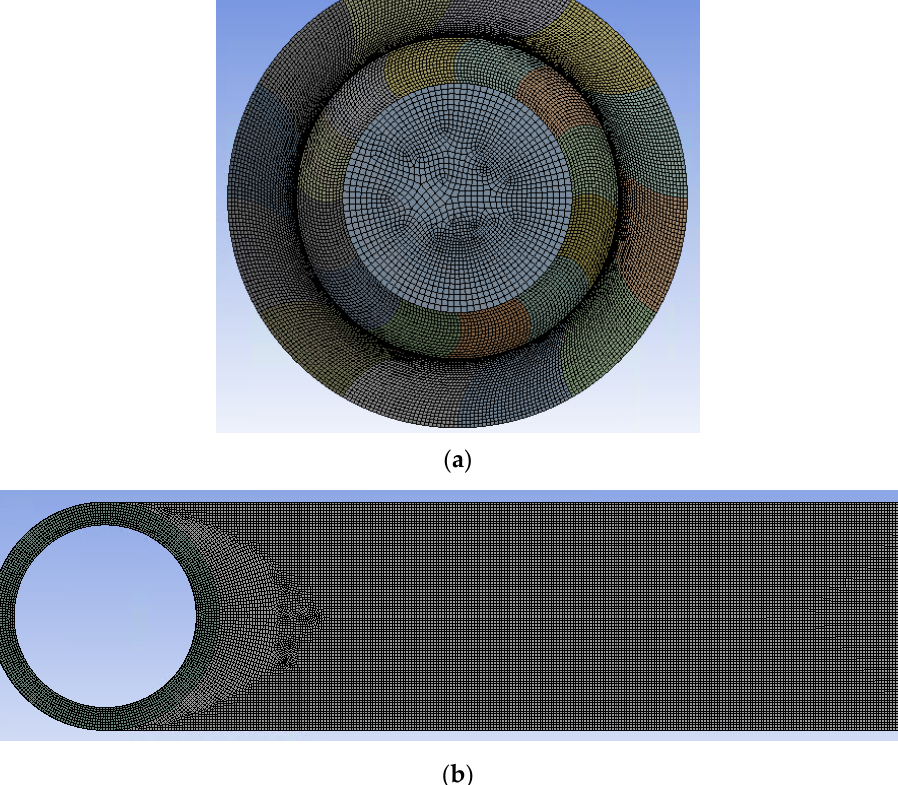
Figure 3. Spatial discretization of ( a ) VAWT and ( b ) inner domain section.